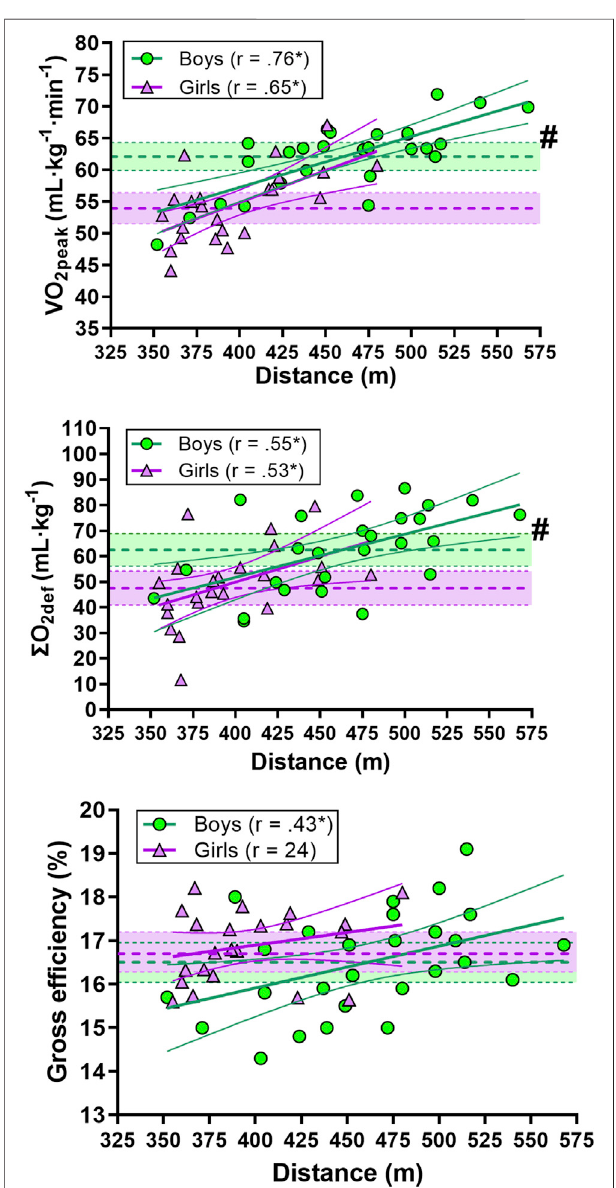
FIGURE3| Correlationbetweenindoorrollerski3-minmaximaluphill(8 ° ) time-trial (TT 3min ) performance and V _ O 2peak , Σ O 2def and gross ef fi ciency (GE). Green circles represent individual values for the boys. Purple triangles representindividualvaluesforthegirls.Shaded areaswithdottedlines in FIGURE 2 | Correlations between indoor rollerski 3-min maximal uphill the middle represent mean ±95% con fi dence interval (CI) (green area for the (8 ° ) time-trial (TT 3min ) performance and age, weight, height and BMI. Green boys and purple for the girls). Thick and narrow lines represent the best fi t circles represent individual values for the boys and purple triangles represent regression line and the 95% con fi dence bands (green lines for the boys and individual values for the girls. Shaded areas with dotted lines in the purple for the girls). * Correlation is signi fi cant at the 0.05 level. # signi fi cant middle represent mean ±95% con fi dence interval (CI) (green areas for the difference between boys and girls. ( Continued )